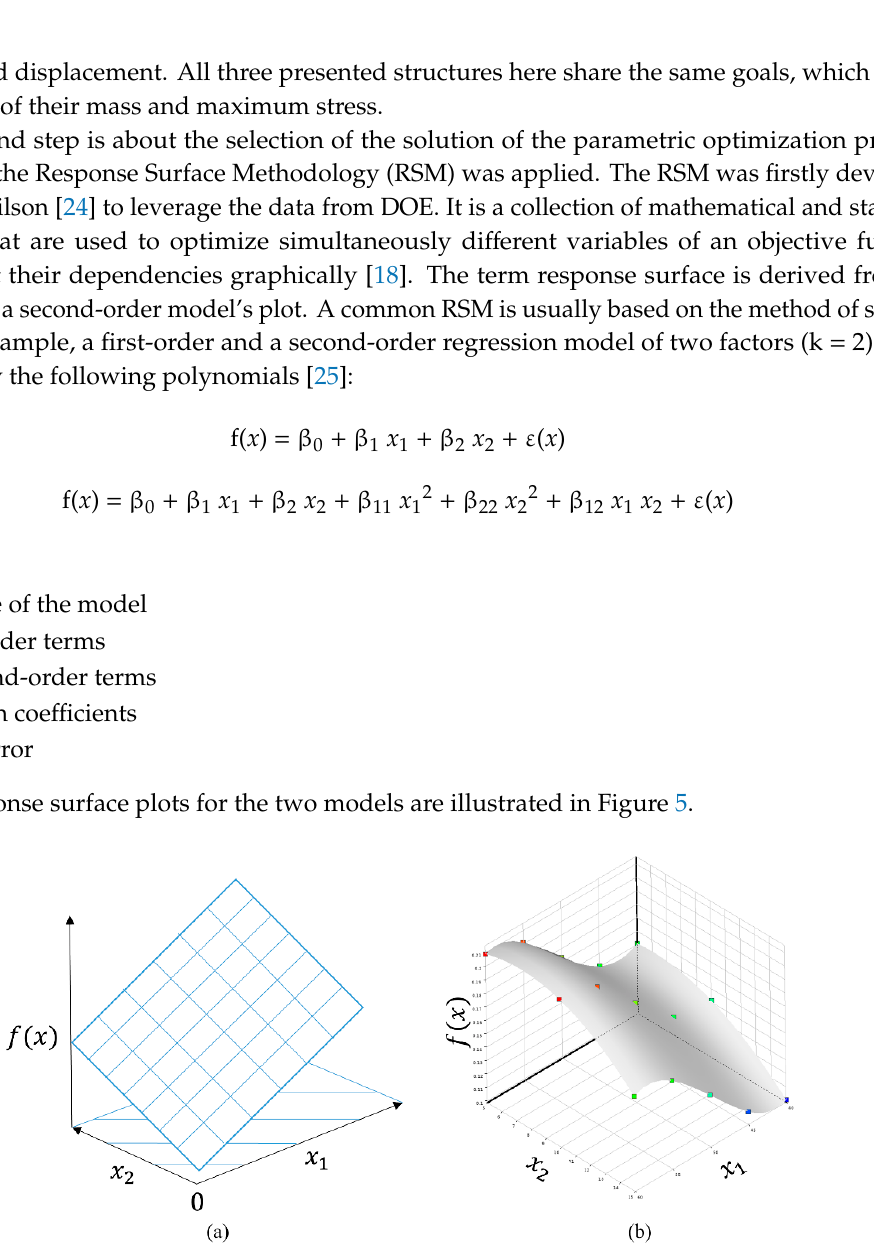
Figure 5. Examples of response surface plots: ( a ) Response surface plot of a first-order regression model, and ( b ) response surface plot of a second-order regression model.